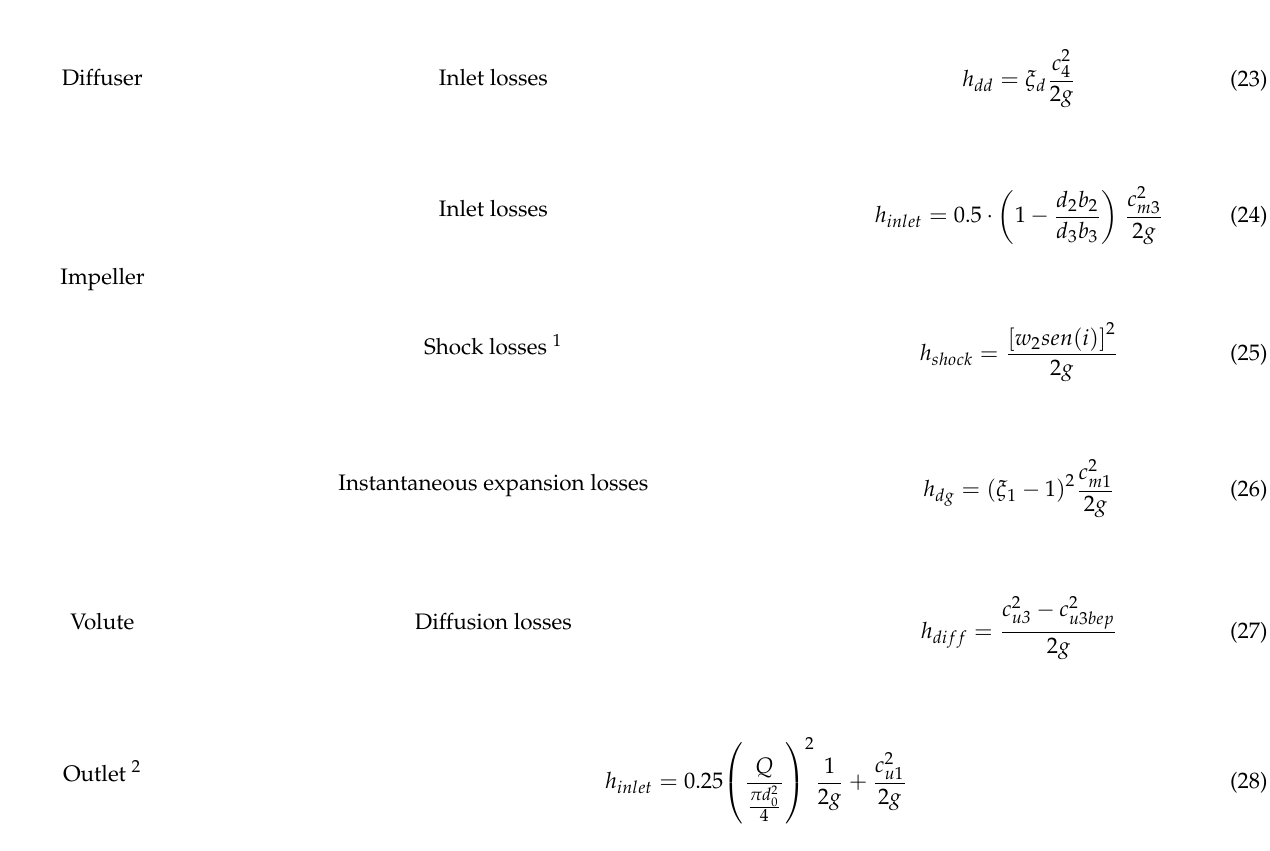
Table 4. Dynamic losses in turbine operation.